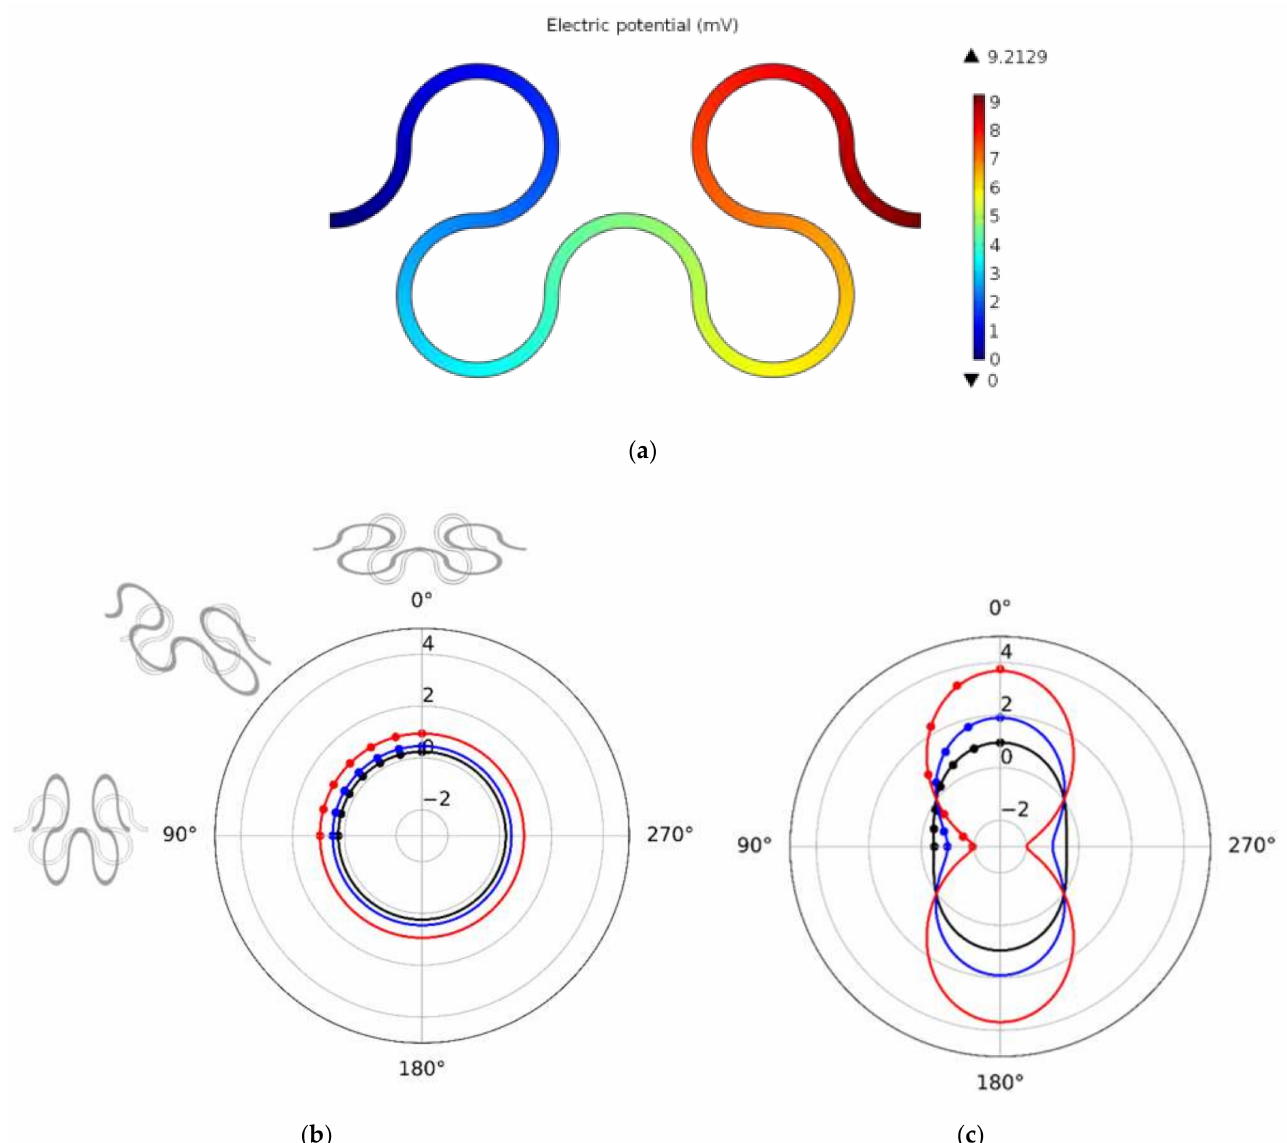
Figure 3. ( a ) Electric potential in the SFC elementary cell sensor as obtained by FEM simulation for a 90 ◦ load case and 1% of strain; ( b ) ∆ R / R in dependence of the direction of applied strain in a polar coordinate view for the SFC and ( c ) for a linear gauge with same conductor cross-section for comparison. Dots represents data obtained by FEM simulation and lines are obtained by symmetry considerations and interpolation. The color indicates the magnitude of strain (black = 0.5%; blue = 1%; red = 2%). The images at 0 ◦ , 45 ◦ , and 90 ◦ illustrate the deformation pattern for these load